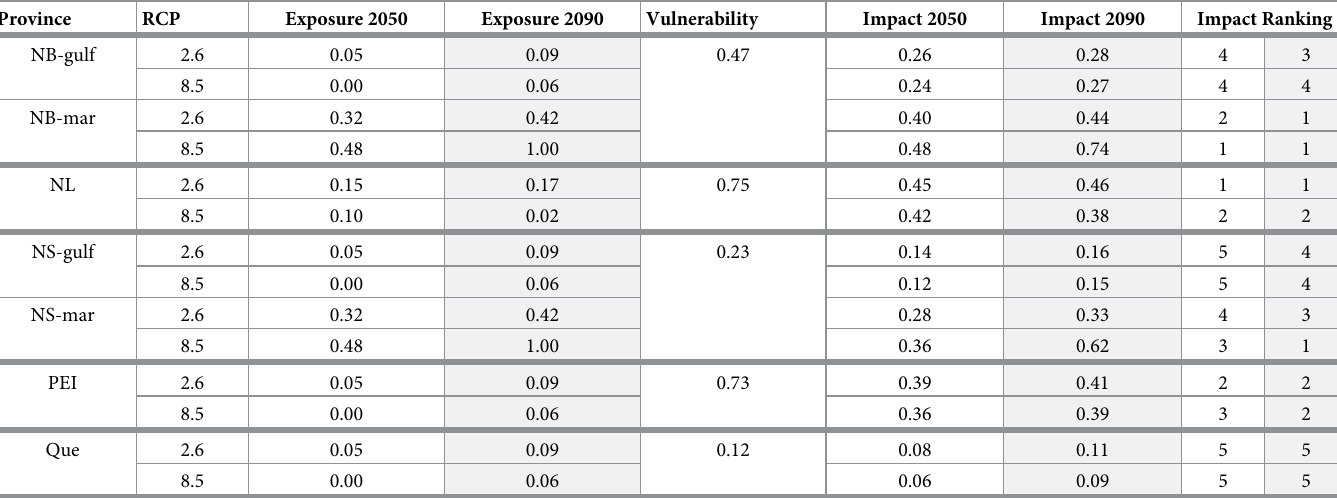
Table 5. Impact index components and scores. Components are presented as final normalised scores. The exposure scores are presented in columns 3–4 as quartets of climate scenario and future time-step. The vulnerability scores (column 5) are the average (i.e., equally weighted combination) of sensitivity (Table 3) and adaptive capacity (Table 4) as indicated by Fig 4. The final index score quartets (column 6–7) are the average (i.e., equally weighted combination) of the relevant exposures and vulnerabili- ties. The final two columns indicate rank for each unique potential impact score: 1-high, 2-moderate, 3-low, 4-minimal and 5-least potential for impact (all categories except 3-low, represent 6 unique scores– 3-low only represents 4 unique